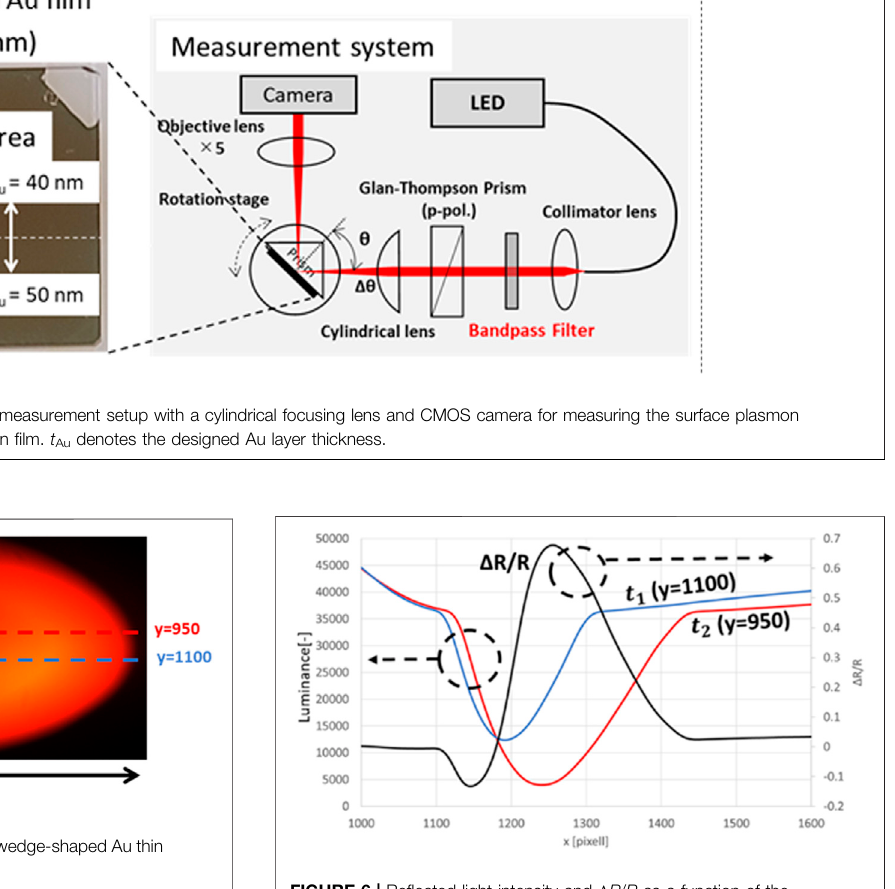
FIGURE 6 | Re fl ected light intensity and Δ R / R as a function of the position of the image x based on the luminance distributions of y (cid:2) 950 and 1,100 in Figure 5